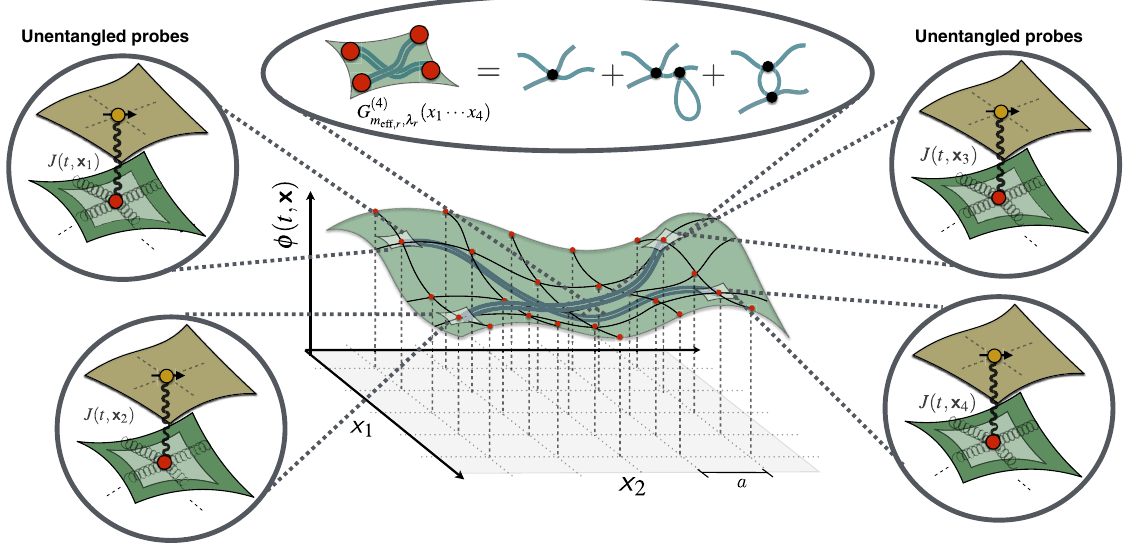
FIG. 3. Scheme of the 4-spin interactions for the harmonic sensors: four distant Ising spins at positions x 1 , · , x 4 are coupled to the real scalar field φ( t , x ) locally by harmonic Ising-Schwinger sources J ( t , x i ) ∝ sin (ω J t − k J · x i ) . As a result, there are 4-spin Ising interactions mediated by the scalar bosons, the strength of which will be related to a connected four-point propagator. In the upper inset, we show that in the presence of quartic couplings, these interactions will include all possible scattering events that involve two incoming and two outgoing virtual bosons, together with internal loops due to the self-interaction vertices.